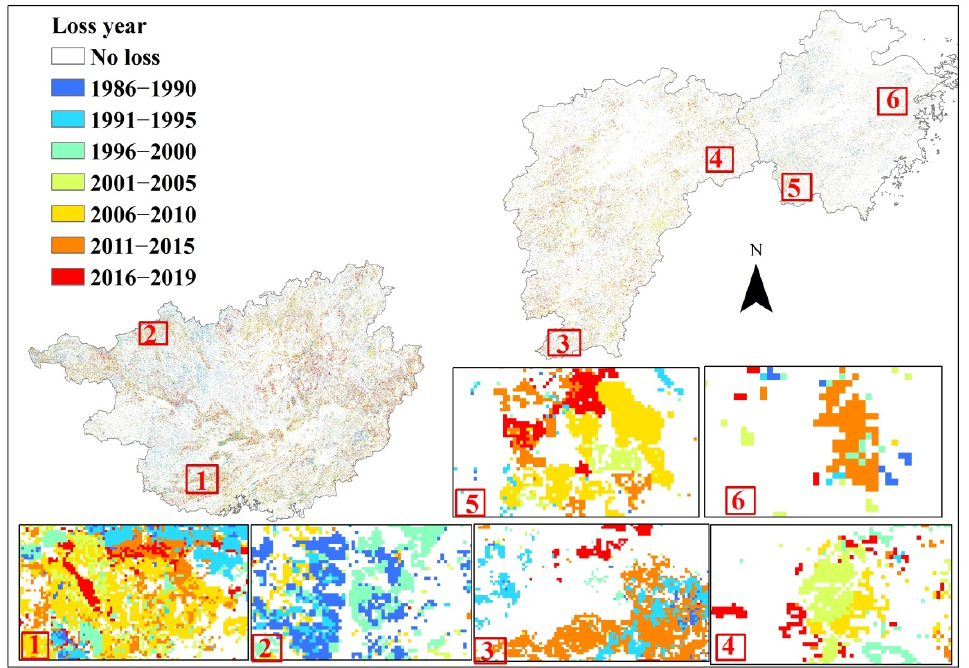
Figure 7. The spatial and temporal distribution of detected forest loss areas in Guangxi, Jiangxi, and Zhejiang Provinces during 1986–2019. Note: the six boxes at the bottom represent the magnified typical forest loss areas. Note: the numbers (1–6) denote the selected typical areas in the three provinces.